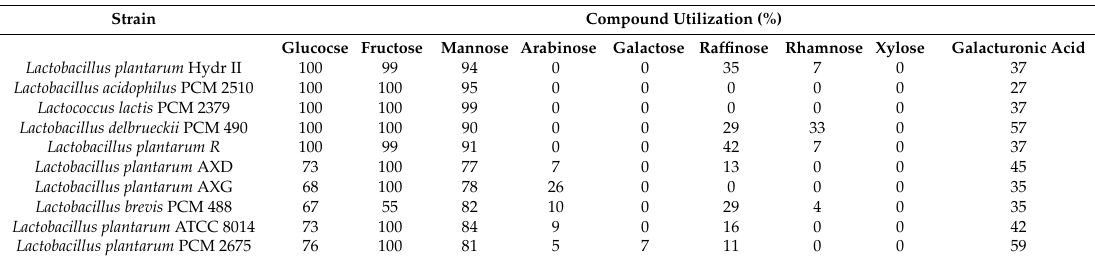
Table 2. Carbohydrate utilization profiles of lactic acid bacteria after fermentation of sugar beet pulp hydrolyzates (medium obtained acc. to 3.1.2.).